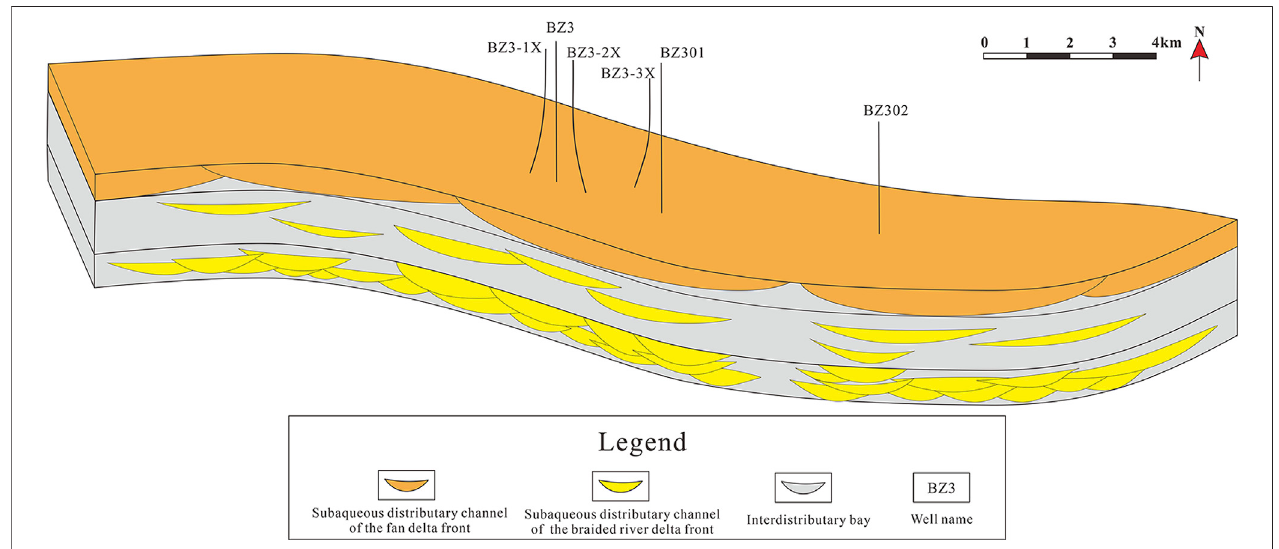
FIGURE 5 | Sedimentary facies of the Bashijiqike Formation in Bozi 3 gas